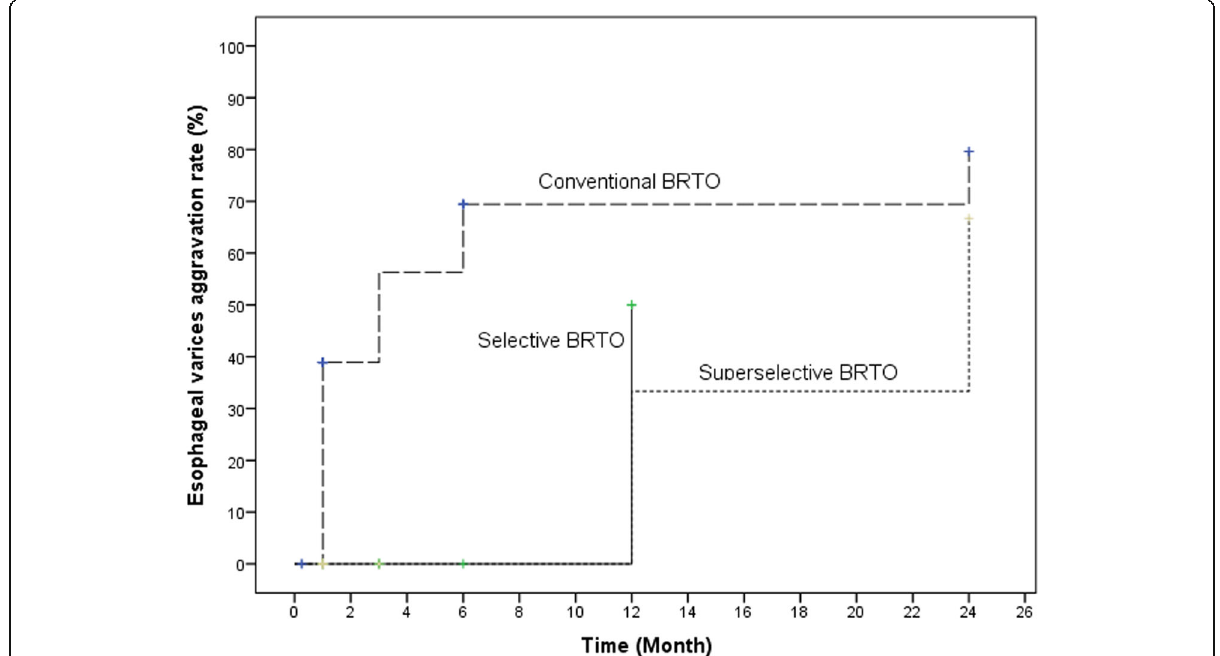
Fig. 7 Esophageal varices aggravation after conventional, selective. and superselective BRTO.Kaplan-Meier curves show that Es.V aggravation rates were significantly higher after conventional BRTO than both selective and superselective BRTO ( p = 0.01 and 0.03, respectively).